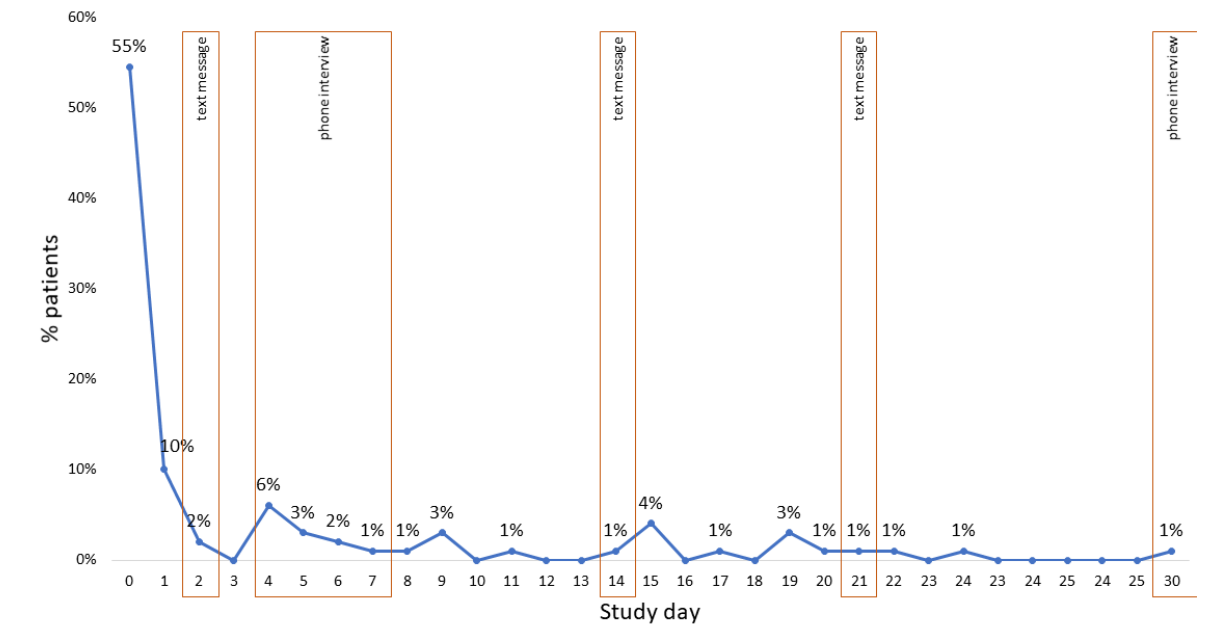
Figure 2. Percentage of users installing the app per study